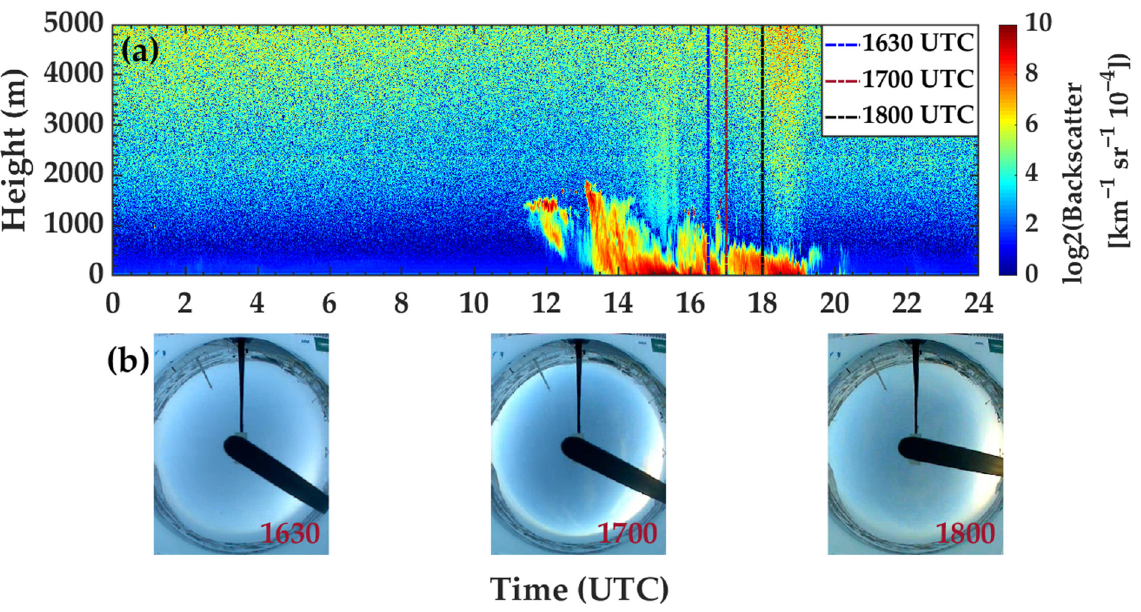
Figure 9. ( a ) Backscattered echo of ceilometer from on 9 October 2016. Blue dotted line corresponds to 1630 UTC, red dotted line corresponds to 1700 UTC, and black dotted line corresponds to 1800 UTC. ( b ) TSI images at 1630 UTC, 1700 UTC, and 1800 UTC on 9 October 2016.